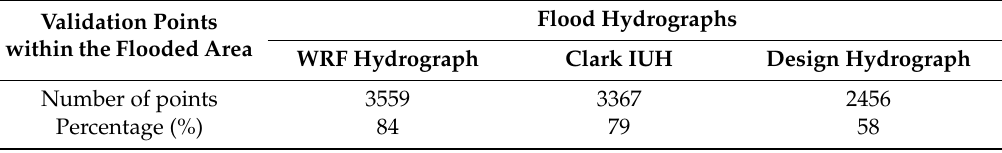
Table 4. Validation statistics for all examined flood extent based on the flood hydrographs used.